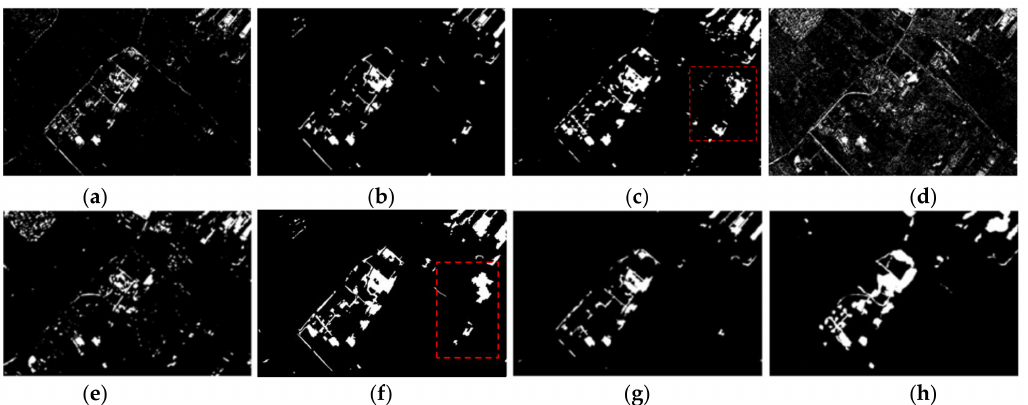
Figure 12. Binary changed maps of SZTAKI data set generated by different methods: ( a ) CVA;